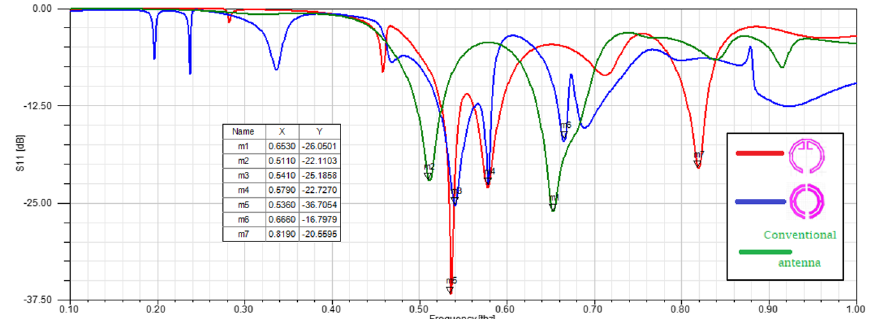
Fig. 6 Simulated reflection coefficient of microstrip patch antenna loaded with